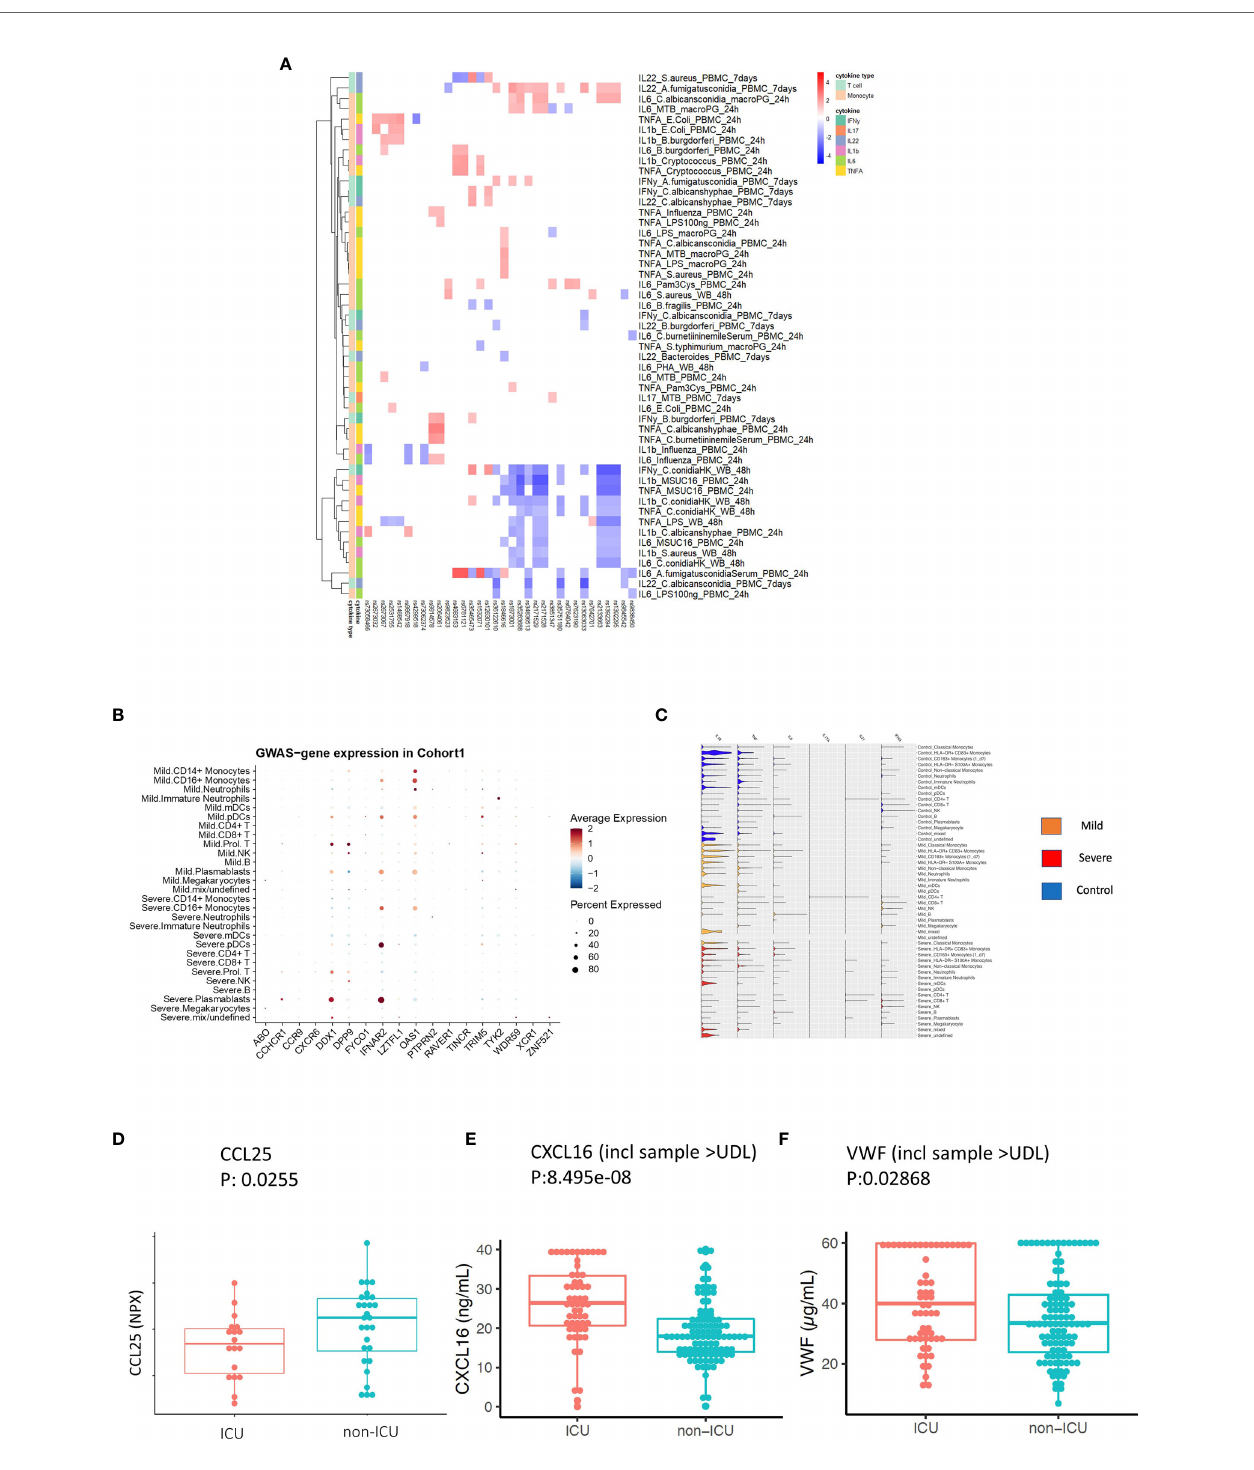
FIGURE 5 | Replication and validation. (A) Heatmap showing the association between 3p21.31 locus and immune traits in GenoMICC study. The red color corresponds to higher cytokine production leaded by risk allele in COVID-19 GWAS pro fi les, whereas blue color indicates lower cytokine production leaded by risk allele in COVID-19 GWAS pro fi les. (B) Dot plots of expression of GWAS genes in single-cell transcriptomics of COVID-19 patients. The GWAS genes were selected from the Severe COVID-19 GWAS (1) and GenOMICC study (30). (C) Violin plots of the expression of monocyte-derived cytokine genes and T cell derived cytokine genes in COVID-19 Berlin cohort based on single cell RNA-seq data. (D) A boxplot of the differential protein levels [NPX (Normalized Protein eXpression)] of CCL25 between 18 ICU and 28 non-ICU COVID-19 patients from another independent cohort. (E) A boxplot of the differential protein levels of CXCL2 (ng/mL) between 57 ICU and 102 non-ICU COVID-19 patients. (F) A boxplot of the differential expression of VWF (ug/mL) between 57 ICU and 102 non-ICU COVID-19